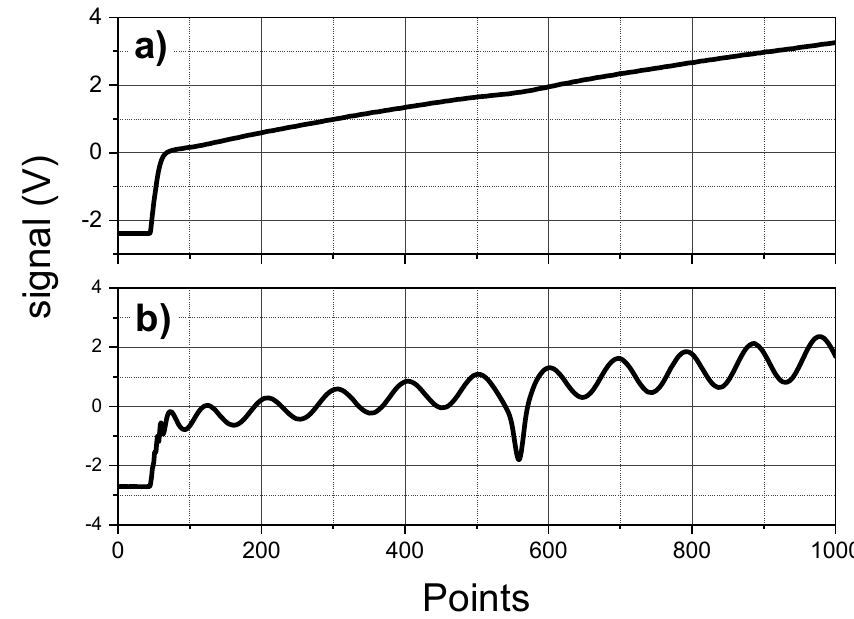
Figure 5. Example of a typical acquired signals. ( a ) main channel with ambient CO; ( b ) reference channel with reference cell containing CO at low pressure and